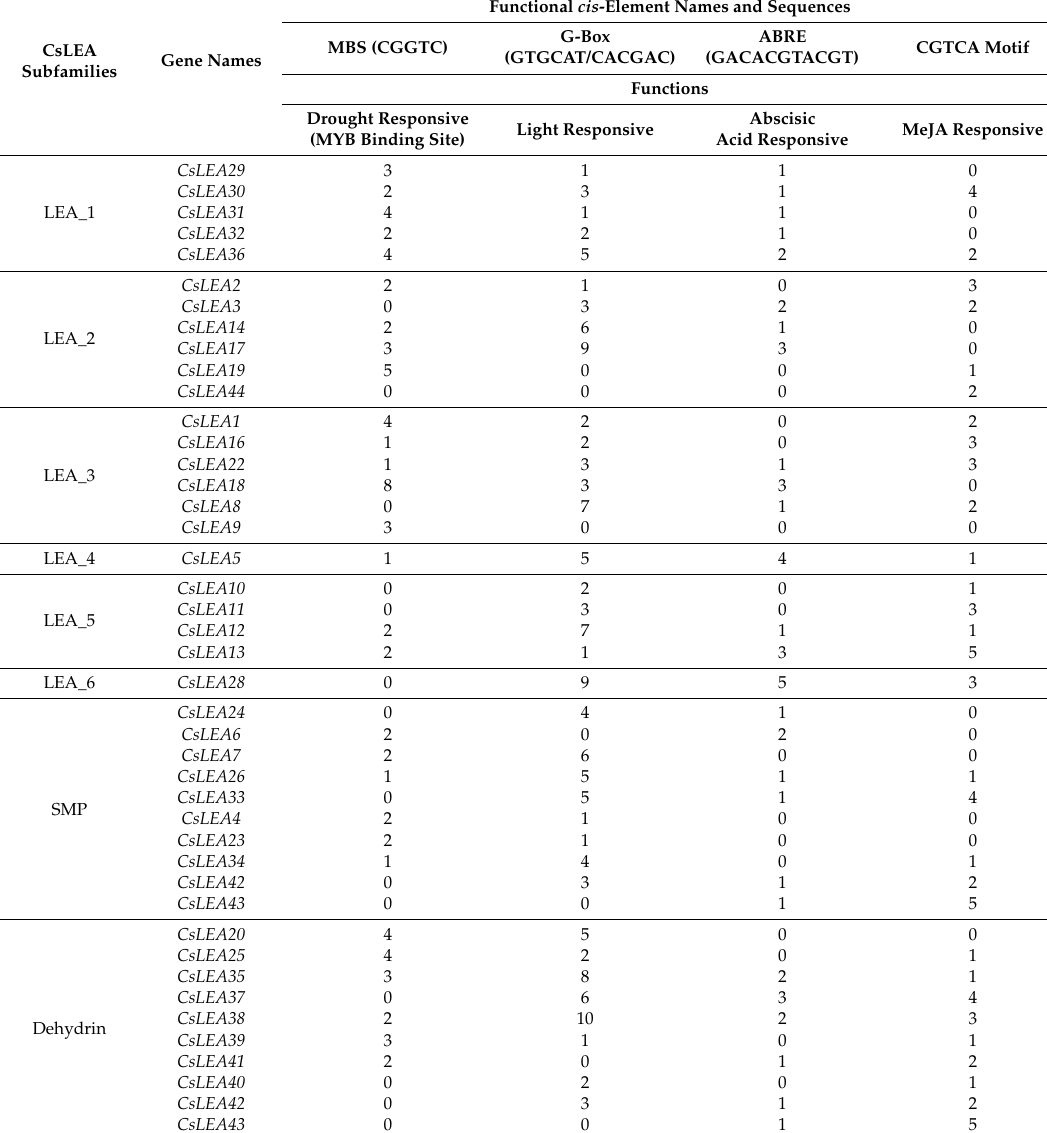
Table 1. Stress-related cis -regulatory elements in 44 C. songorica LEA gene promoters.